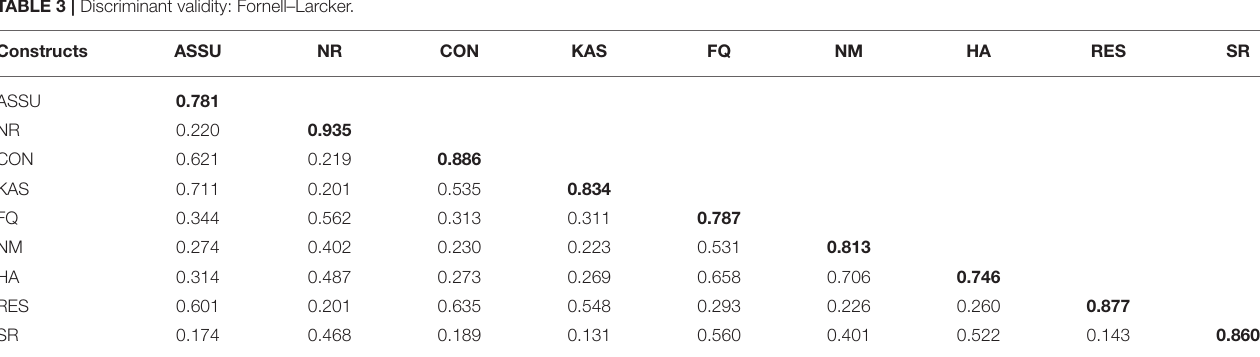
TABLE 3 | Discriminant validity: Fornell–Larcker.